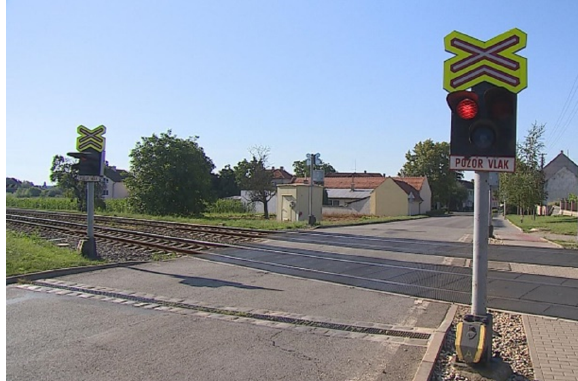
Figure 4. RC secured by a light device without mechanical barriers [ ct24.ceskatelevize.cz ].